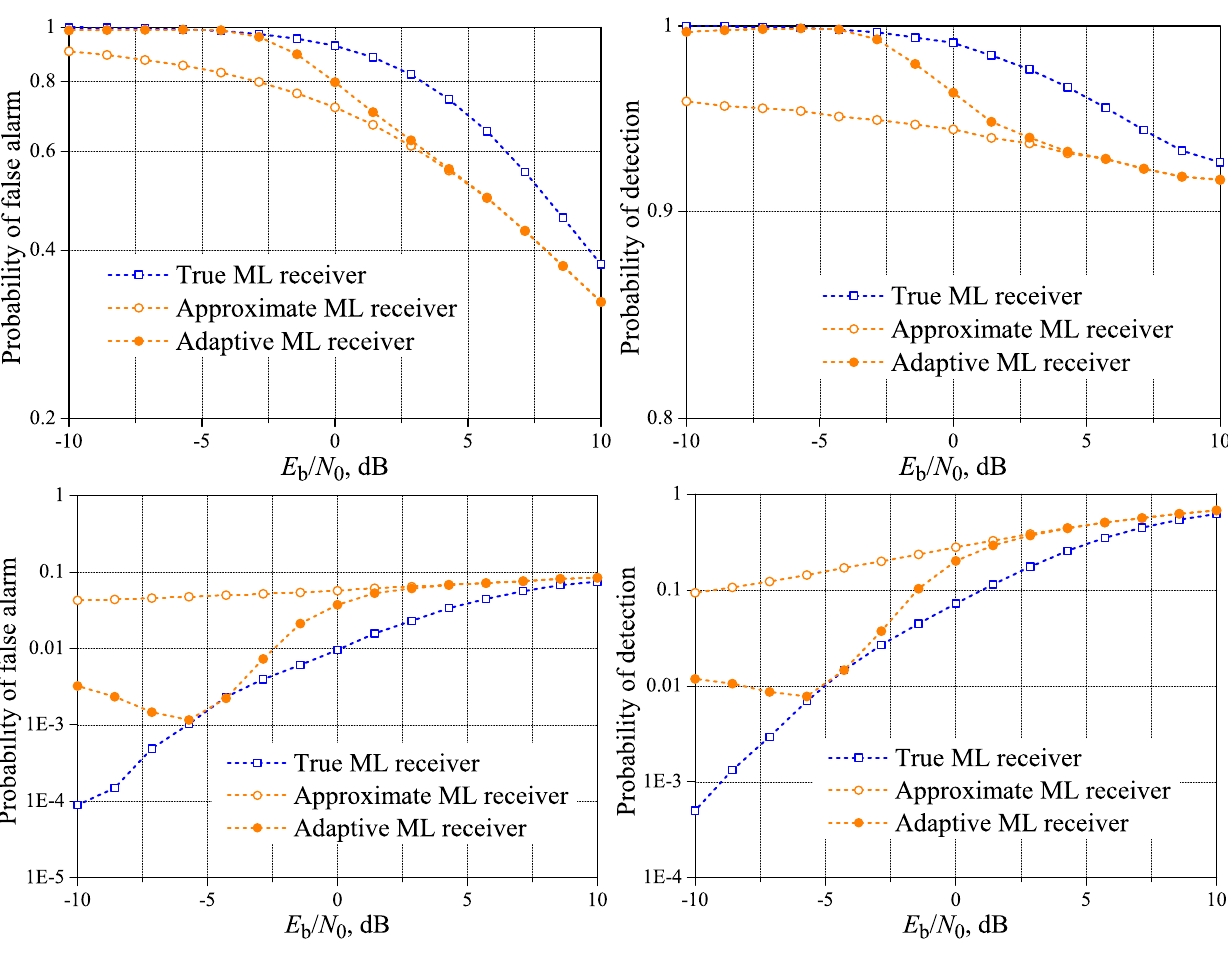
Figure 12. Performances of the improved ML (adaptive), true ML and approximate ML receiver for: M = 5 and K = 1 ( top ); and M = 5 and K = 5 ( bottom